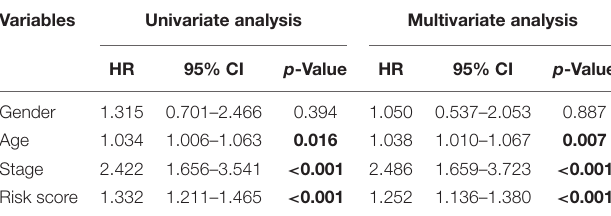
TABLE 2 | Univariate and multivariate Cox proportional hazards regression analysis of the RBP-related signature and clinical factors with overall survival in the training set.